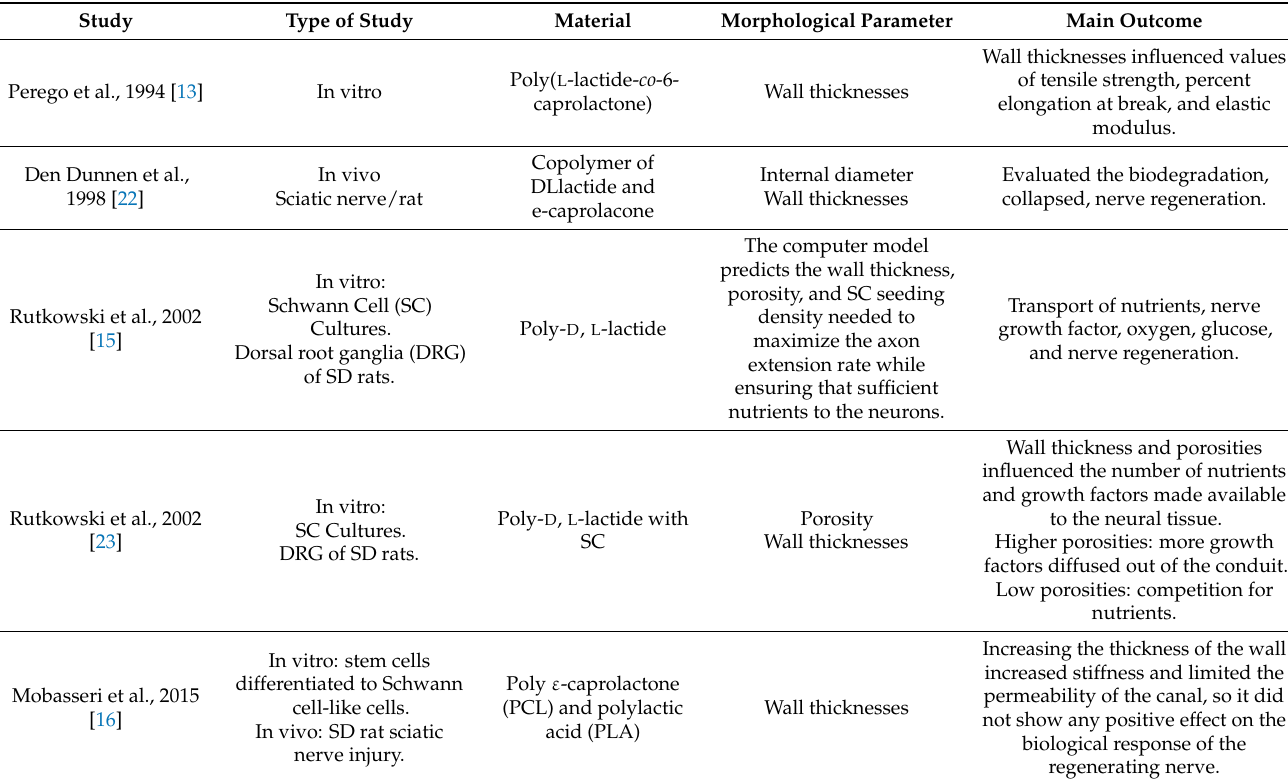
Table 2. Studies evaluating the NGC Wall